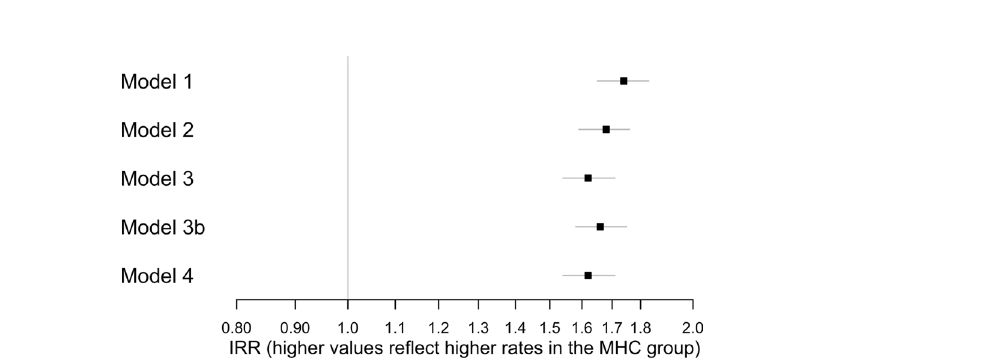
Figure 1. Associations between multiple health complaints (MHC) (yes/no) and number of hospital contacts. Presented as incidence rate ratios (IRR) [95% CI]. Model 1 was unadjusted. Model 2: Model 1 + adjustment for age at index date and sex. Model 3: Model 2 + adjustment for existing somatic and psychiatric morbidity. Model 3b: Model 2 + adjustment for Charlson Comorbidity Index (CCI) score. Model 4: Model 3 + adjustment for maternal parity at the birth of the child, the last completed education by the mother, and parental cohabitation (yes/no) at the child’s index